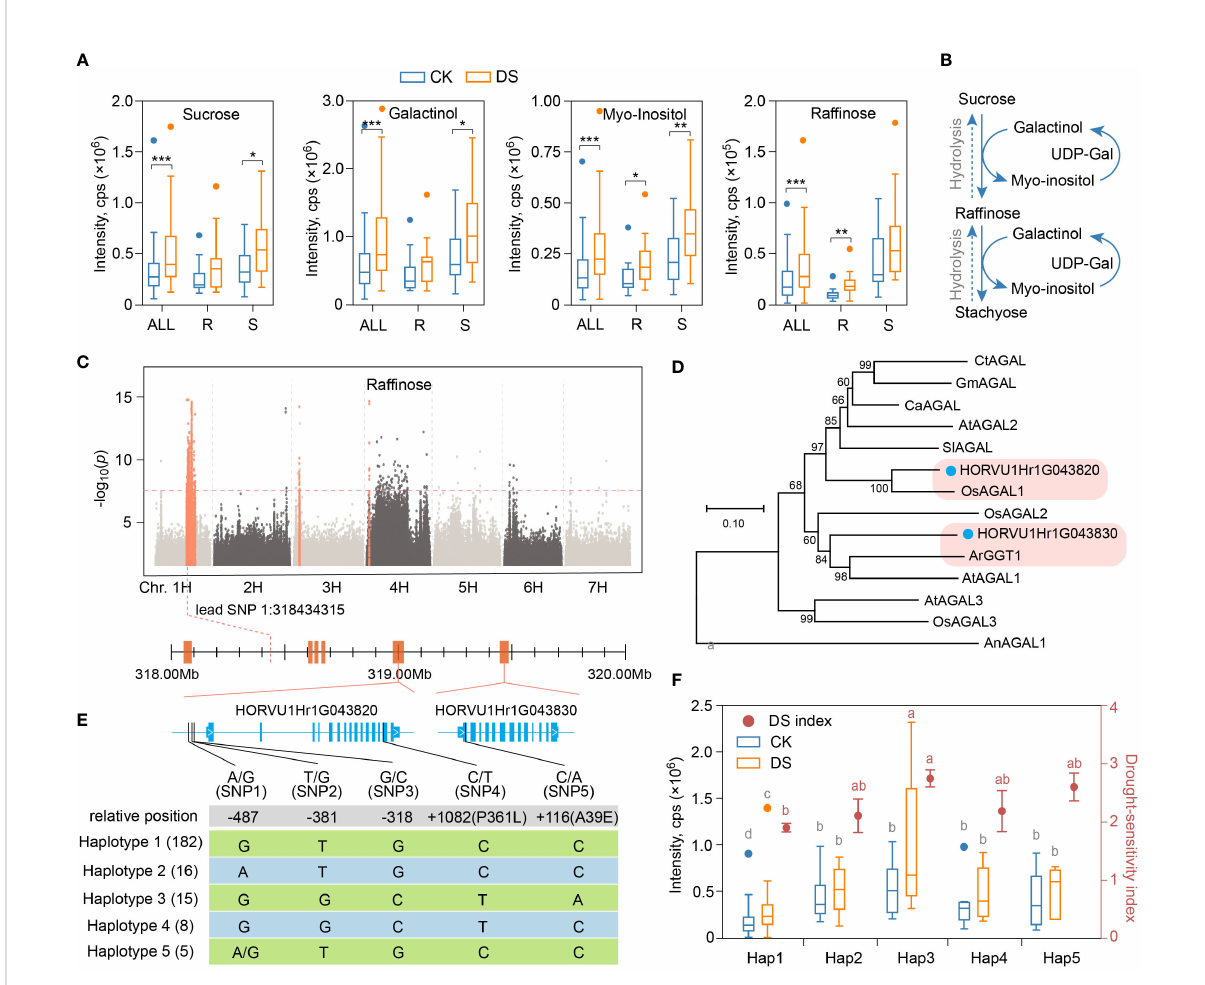
FIGURE 5 Alpha-galactosidase gene regulates raf fi nose synthesis induced by mild drought stress. (A) Boxplot showing the contents of sucrose, galactitol, myo-inositol and raf fi nose in all qingke accession (ALL), drought-resistant qingke (R) and drought-sensitive qingke (S) under CK (blue) and DS (orange) condition. (B) Schematic representation of the biosynthetic pathway of the raf fi nose. (C) Manhattan plot displaying the mGWAS results for the content of raf fi nose in CK condition. Orange dots indicate SNP in signi fi cance association loci, and two gene model of alpha- galactosidase found in the signi fi cance association loci is shown. (D) An unrooted phylogenetic tree of a -galactosidases was constructed as described in Methods. Bootstrap values (based on 1000 replications) are indicated at each node (bar: 0.1 amino acid substitutions per site). (E) The upper part is a representation of the genes in signi fi cant associated loci of raf fi nose from 1H:317.9Mb to 319.5Mb, and the lower part showed nucleotide polymorphisms identi fi ed near the HORVU1Hr1G043820 and HORVU1Hr1G043830, frequency of 5 haplotypes among these two genes in qingke population was labeled. (F) Raf fi nose content (boxplot, corresponding to the left y axis) and drought-sensitivity index (dot plot, corresponding to the right y axis) of qingke corresponding to the fi ve alleles described in fi gure E under CK (blue) and DS (orange) condition, different letters on boxplot indicate signi fi cant differences according to LSD procedure after one-way ANOVA at P -value<0.05, grey and red letters indicate metabolite content and DSI, respectively. Student ’ s t-test, P-value < 0.05, marked with “ * ” P-value < 0.01, marked with “ ** ” P-value < 0.001, marked with “ *** ”